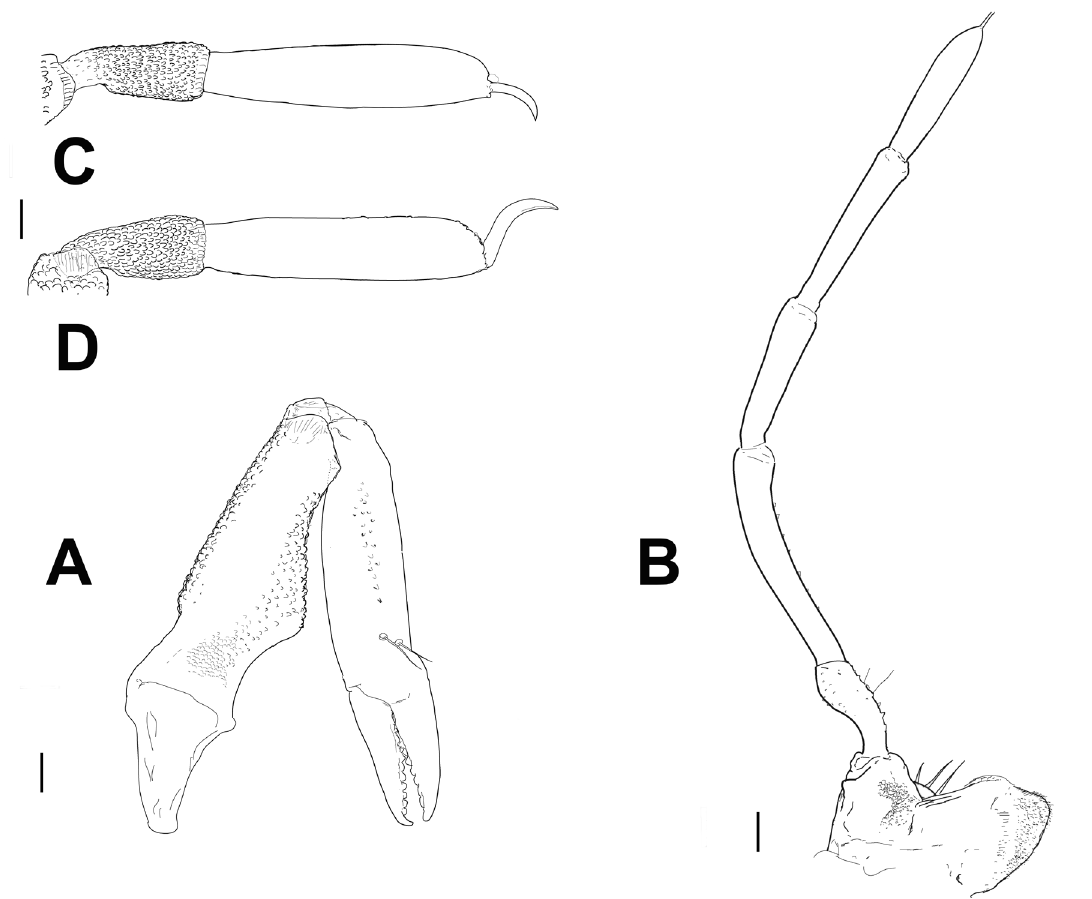
Fig. 9. Siro ozimeci Karaman sp. nov., holotype, ♀ ( GMV 100066). A . Chelicerae, medial view. B . Pedipalp, medial view. C . Basitarsus and telotarsus, leg I. D . Basitarsus and telotarsus, leg IV. Scale bars = 100